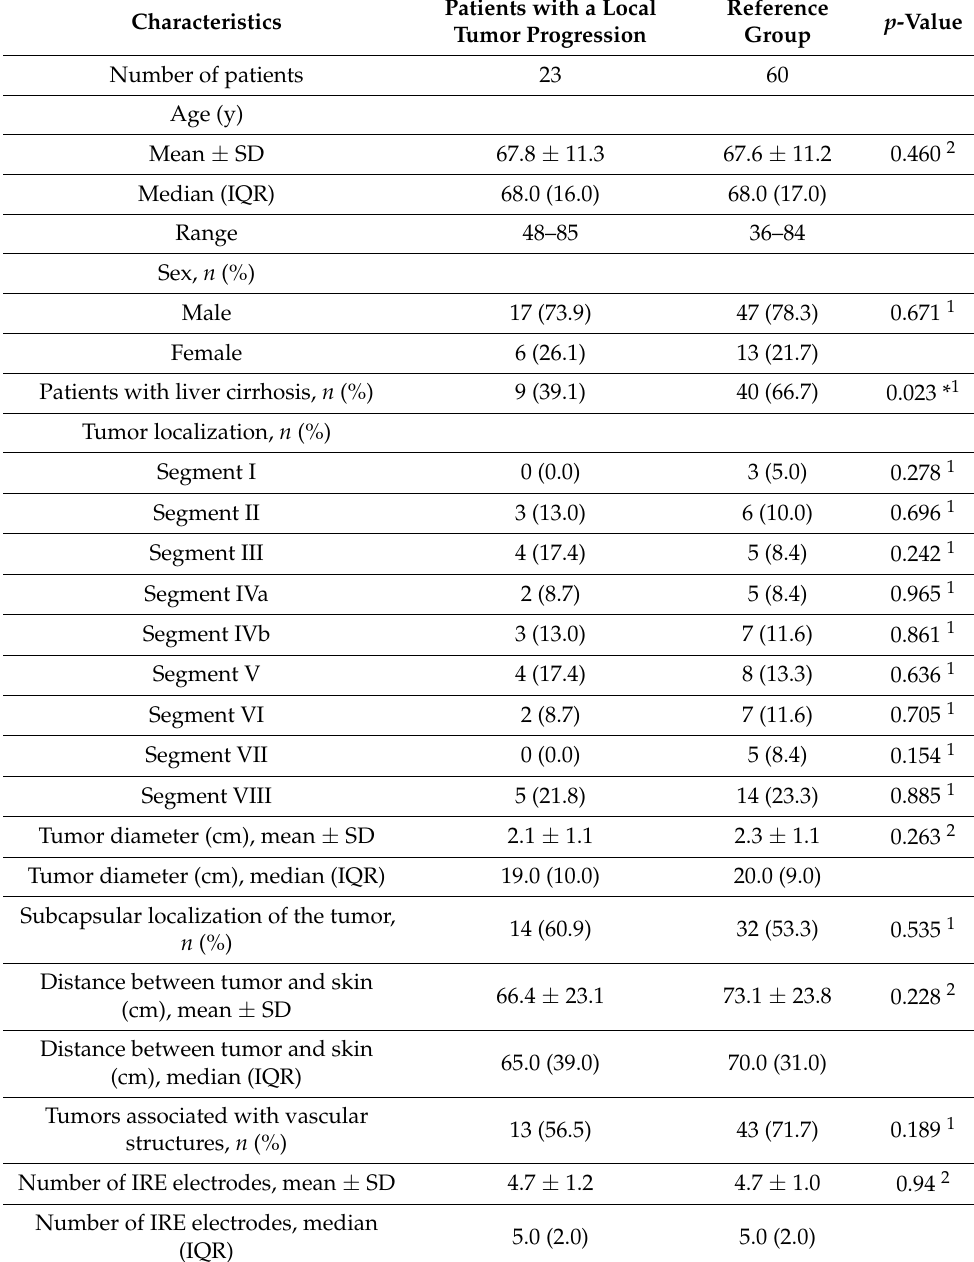
Table 1. Patient and disease